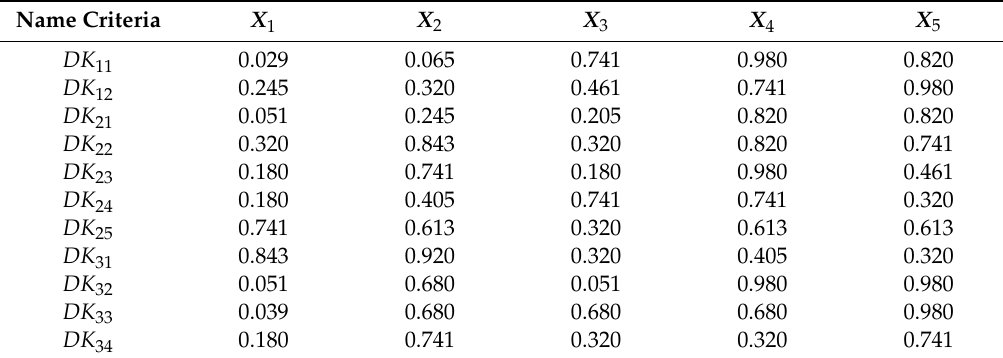
Table 7. Fuzzification of the input signals.